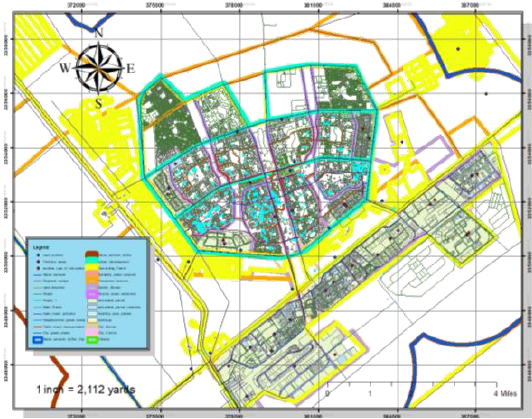
Figure 12. GIS map of all implementation of 10th of Ramadan